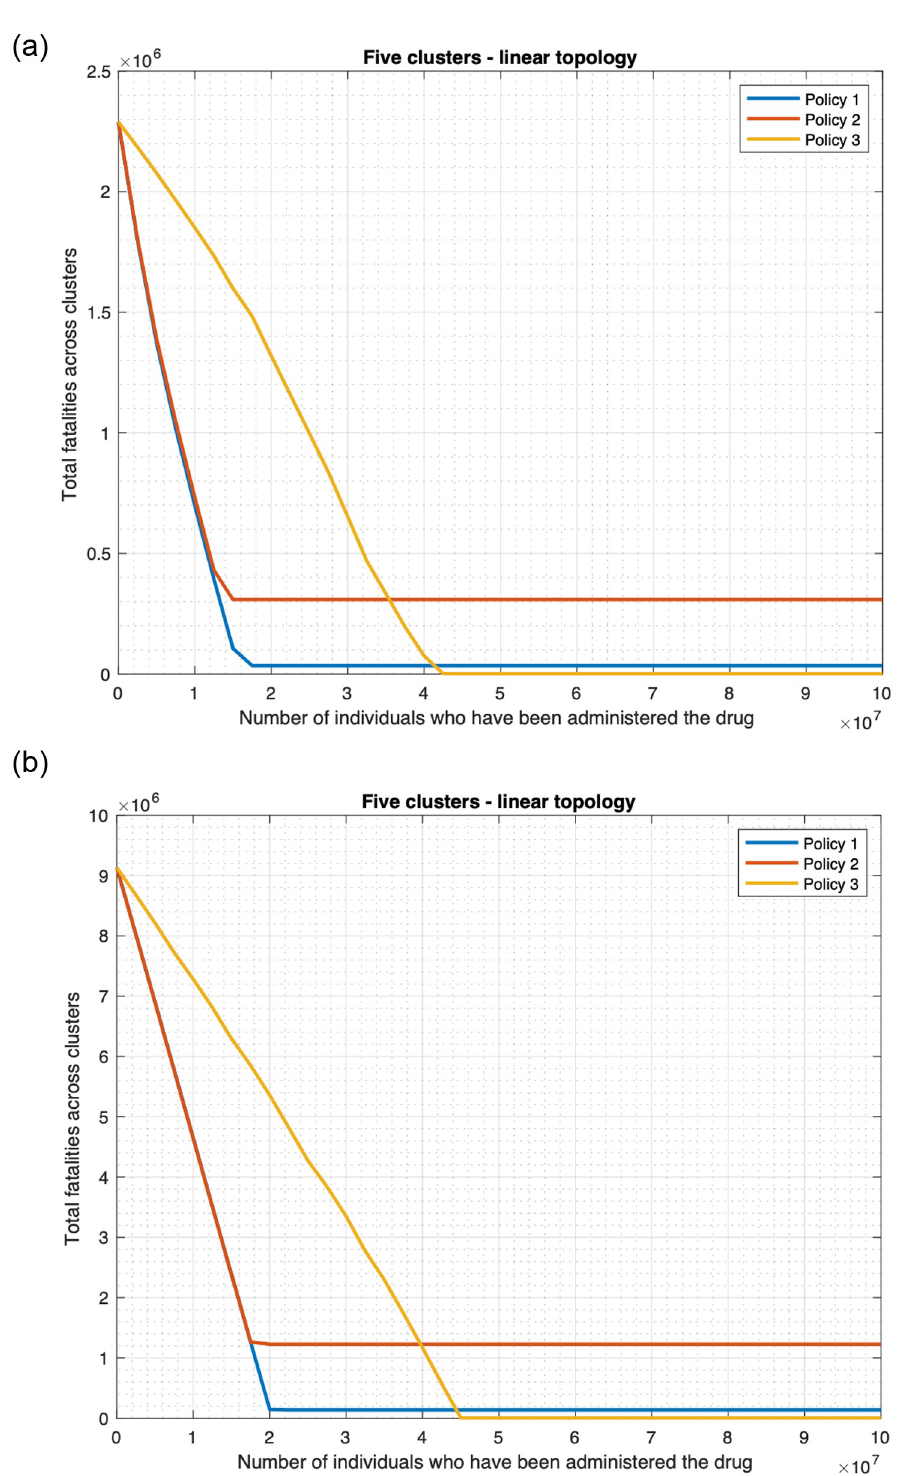
Fig 18. Policies for drug deployment (linear topology). (a) Initially infected individuals are in a peripheral cluster. (b) Initially infected individuals are distributed uniformly across clusters.